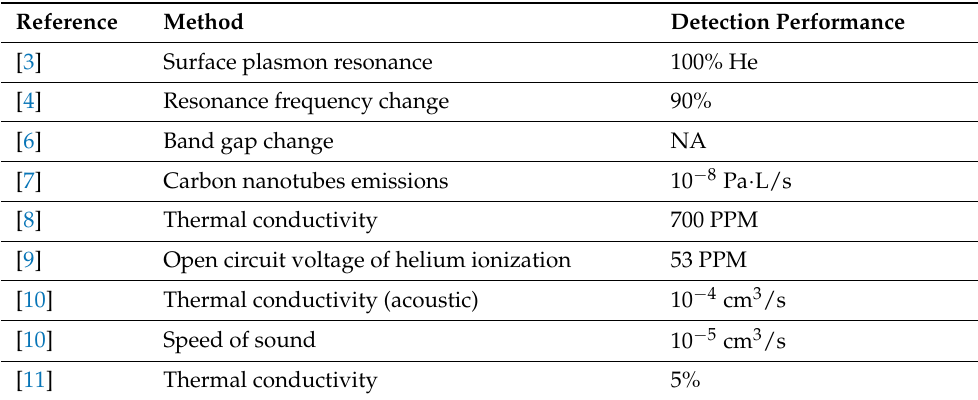
Table 1. Summary of recent helium detection